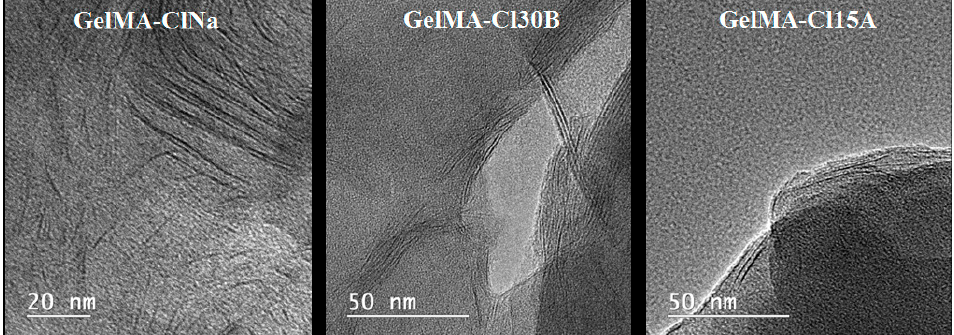
Figure 4. TEM images of synthesized GelMA-based nanocomposites.